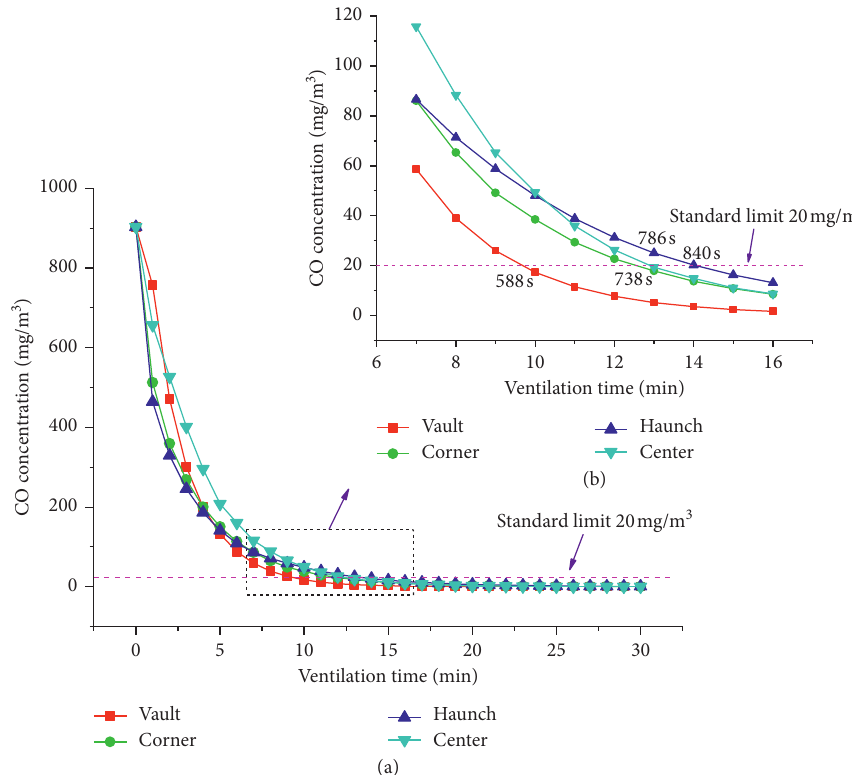
Figure 6: CO ventilation diffusion concentration curve at the point a of the face after